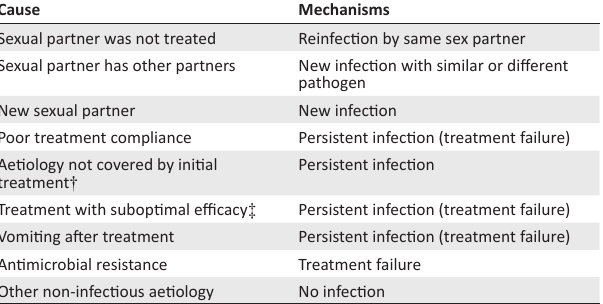
TABLE 4: Reasons for persistent or recurrent sexually transmitted infection episodes.